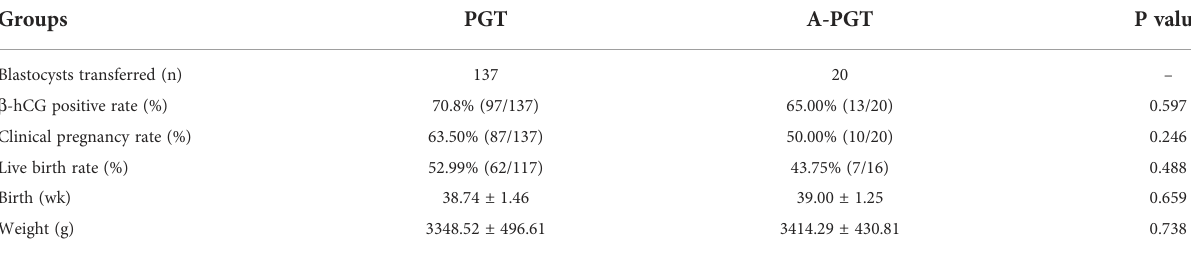
TABLE 3 Comparison of the pregnancy outcomes and birth week between PGT and A-PGT groups. Groups